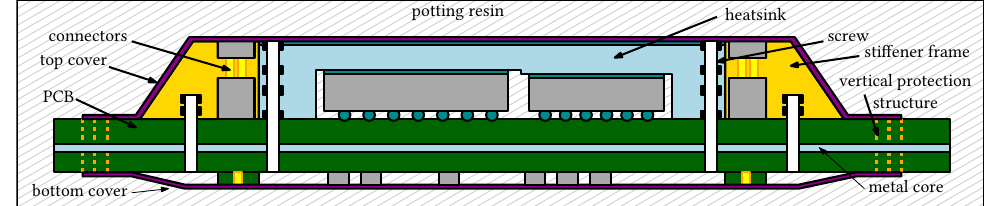
Figure 4: Packaging concept of a device enclosed by the proposed cover.